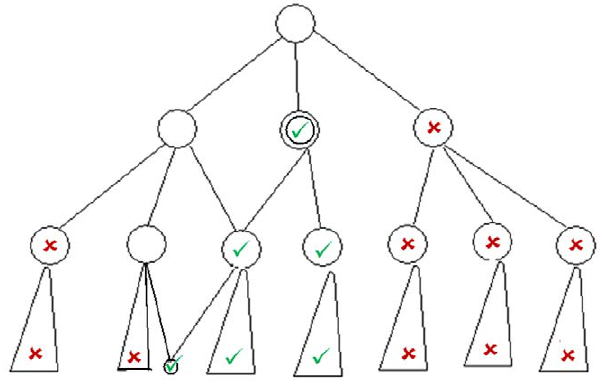
Figure 1. Sample GO DAG showing how we prepared positive and negative training data. The double-circled node indicates the target term. Nodes with green check symbol represent terms included in the positive dataset while those labeled by red X symbol represent terms included in the negative dataset. doi:10.1371/journal.pone.0012382.g001 PLoS ONE |